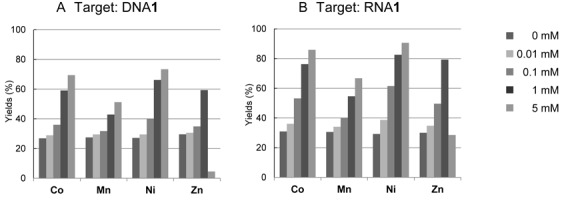
Concentration dependencies of the metal cations on the crosslinking reactions. The reactions were performed under the same conditions as described in Figure 2 with NiCl2, ZnCl2, CoCl2 and MnCl2. After the incubation for 24 h, each mixture was analysed by denaturing gel electrophoresis.